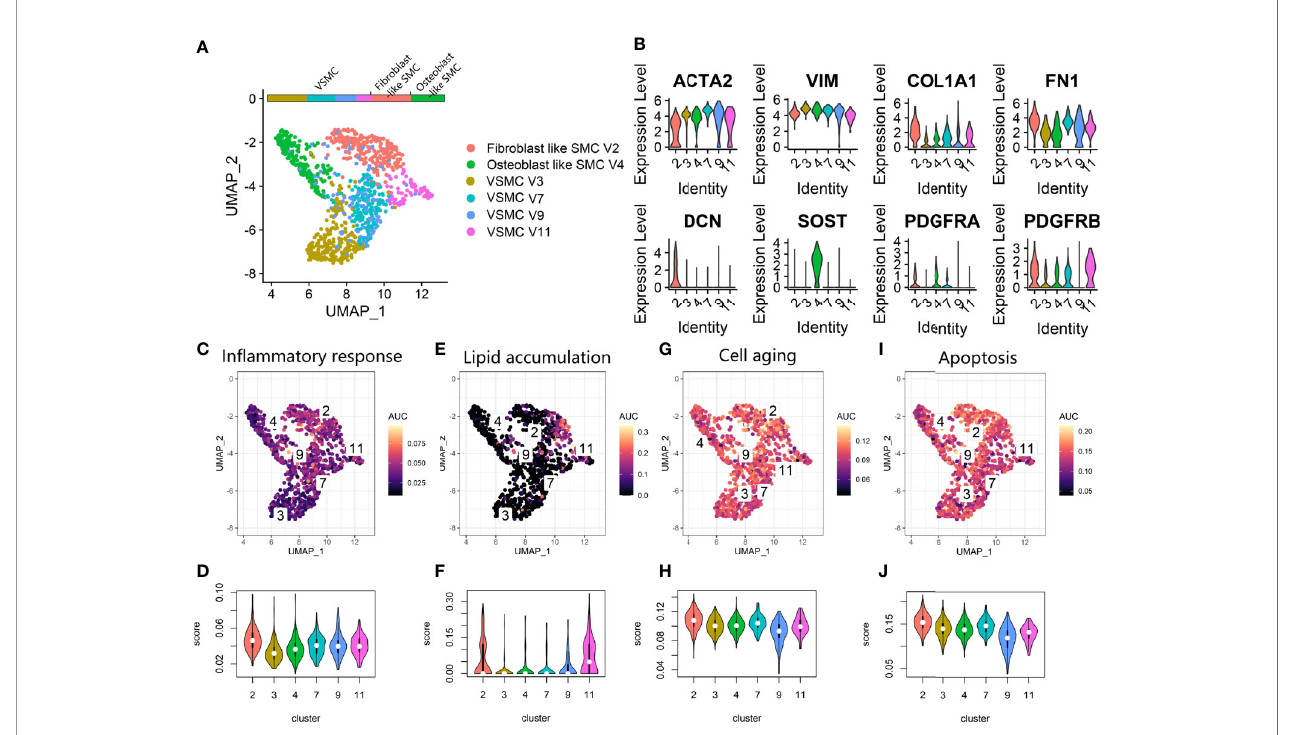
FIGURE 5 | Vascular SMC lineage expression in atherosclerosis. (A) UMAP plot showing vascular SMC lineage clusters. (B) Violin plot for the smooth muscle cell marker genes (ACTA2, VIM), fi broblast marker genes (COL1A1, FN1, DCN), osteoblast marker genes (SOST) and fat cell differentiation genes (PDGFRA, PDGFRB) expression markers in vascular SMC lineage clusters. (C, E, G, I). Scatter plot showing the distribution of AUCell scores of gene sets, including in fl ammatory response (C) , lipid accumulation (E) , cell aging (G) and apoptosis (I) , in the vascular SMC lineage. Yellow indicates a high score, and purple indicates a low score. (D, F, H, J) Violin plots exhibiting the AUCell scores of gene sets, including in fl ammatory response (D) , lipid accumulation (F) , cell aging (H) and apoptosis (J) , in the vascular SMC